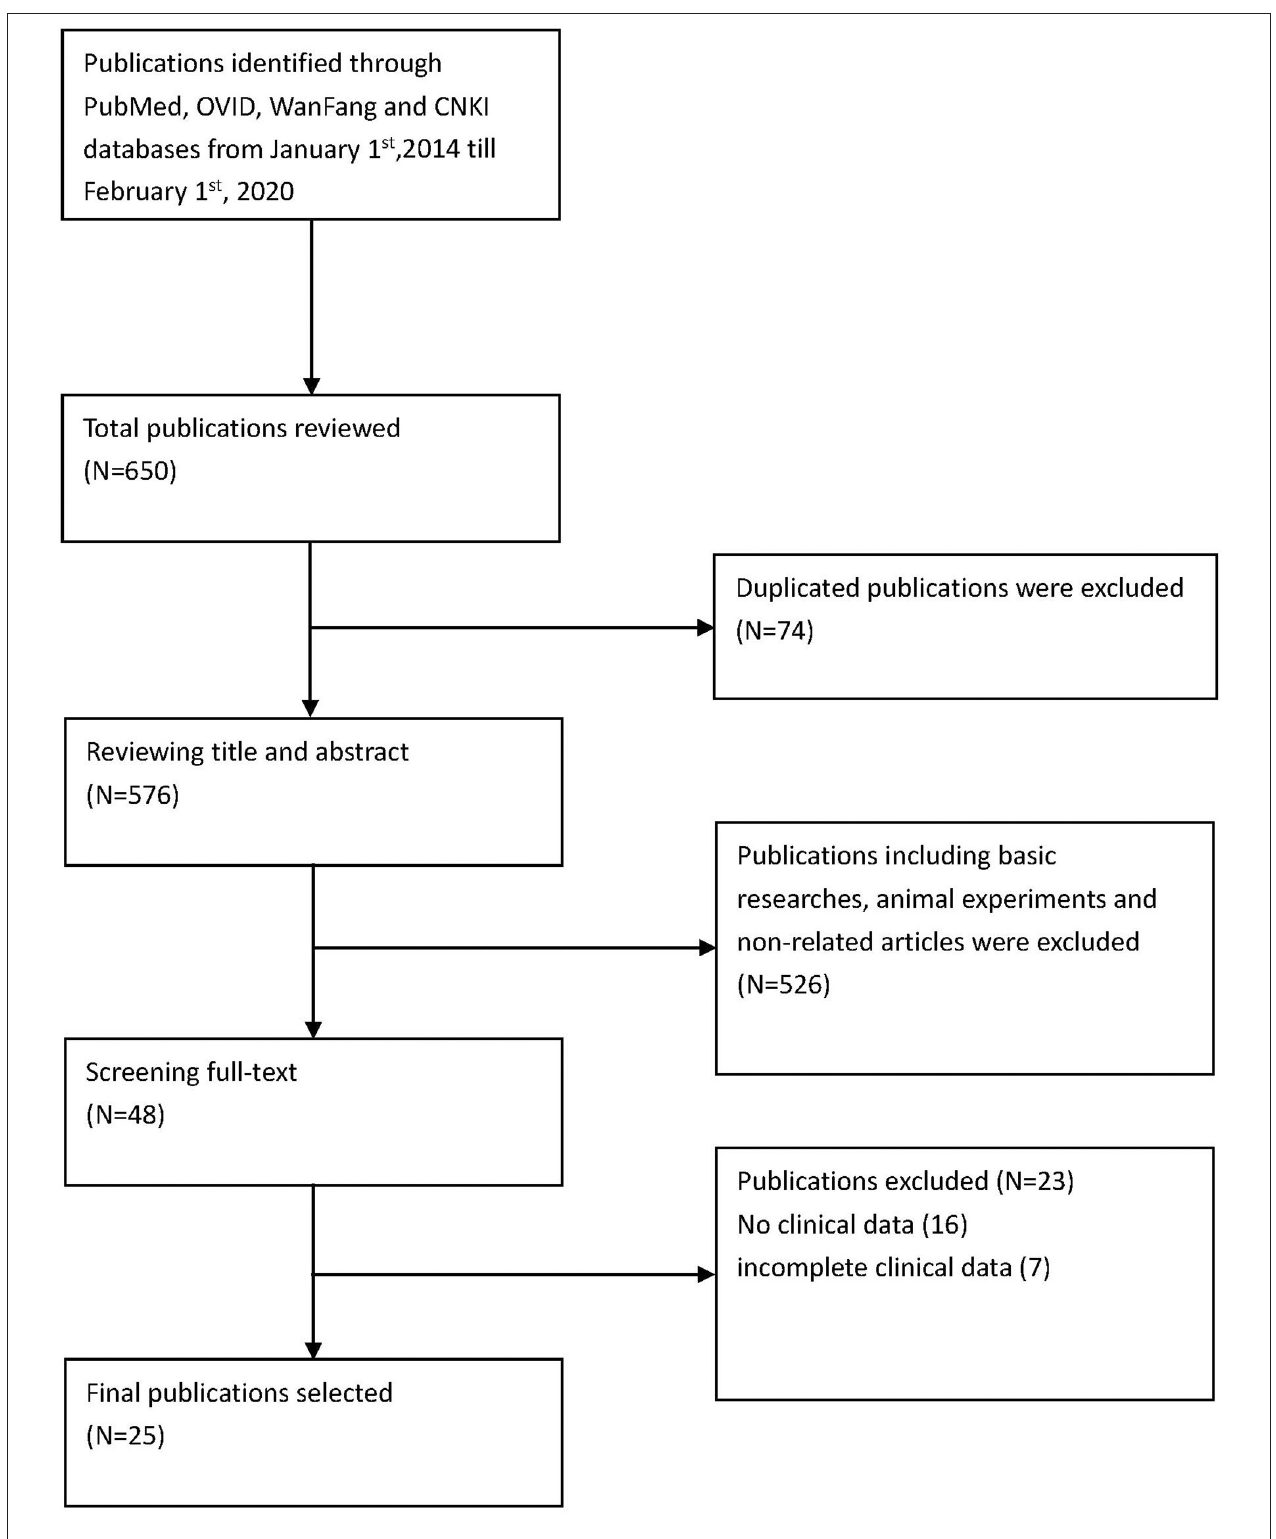
FIGURE 1 | Flow chart of the studies identified in the systematic review.